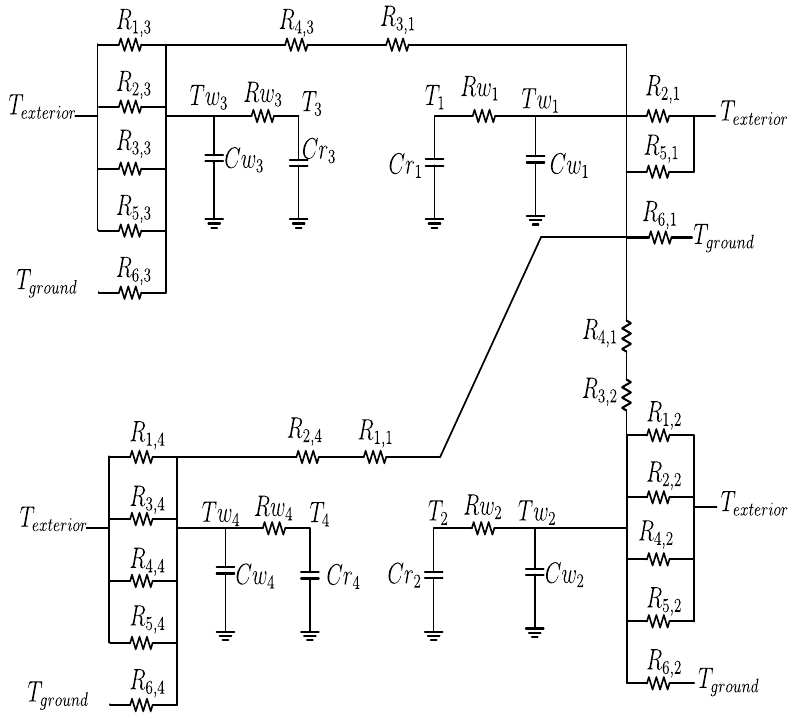
Figure 9. Circuit for a thermal zone with four